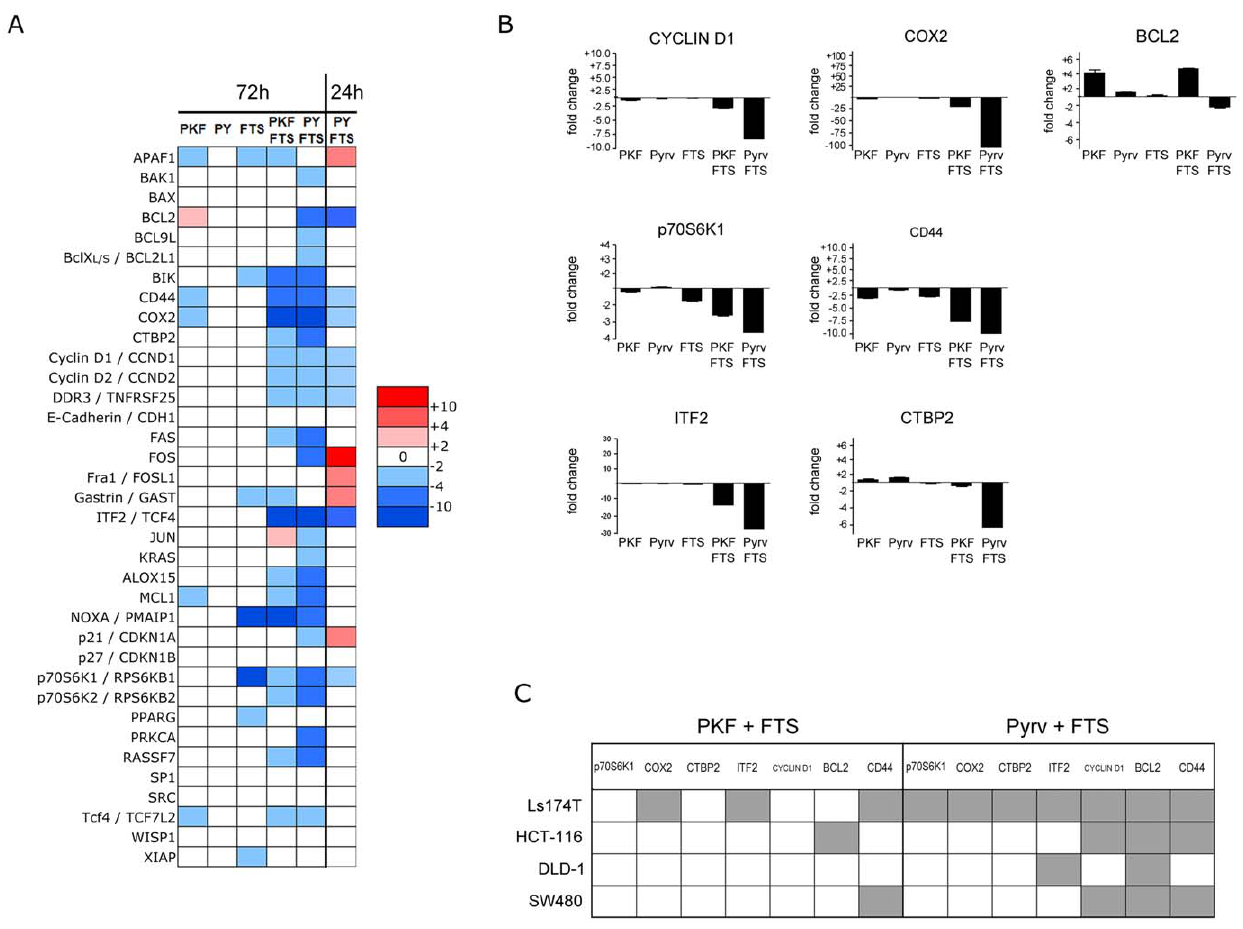
Figure 4. Expression analysis of selected genes after inhibitors treatments. Ls174T cells were treated for 24 or 72 hours with inhibitors and a panel of genes focused on Wnt, Ras and apoptosis pathways was studied by QPCR using a 96-well array ( A ) or standard real-time PCR ( B ). The graphs in ( B ) show expression fold change compared to vehicle-treated controls. ( C ) Summary table reporting real-time PCR data analysis from all cell lines. Filled boxes indicate synergistic effect on gene expression ( . 2-fold change versus every single treatment). PY = pyrvinium.